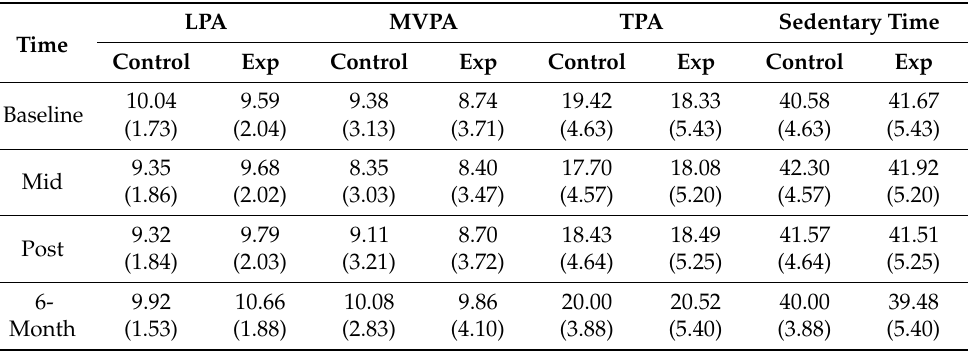
Table 2. Means (standard deviations) of physical activity intensities and sedentary time (min/h) for participating children in the Childcare PLAY policy.